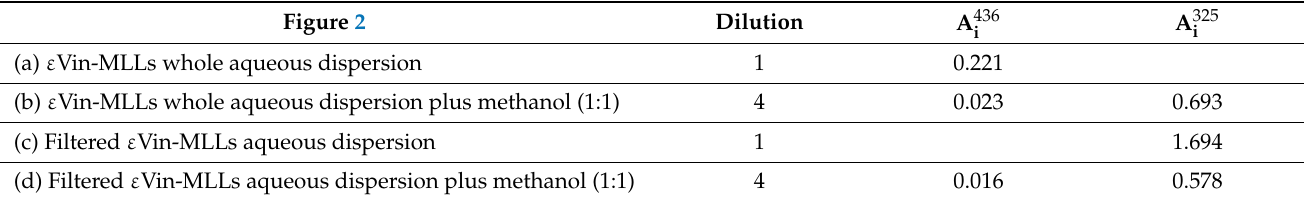
Table 1. Values of absorbance measured at 436 nm (MLLs) and 325 nm ( ε Vin) for a 1 mg mL − 1 dispersion of ε Vin-loaded MLLs containing 40 µ g mL − 1 of ε Vin. Filtration was realized with 5 µ m pore-sized PVDF filters. MLLs were disrupted by addition of an equal volume of methanol. The standard deviation is ± 0.006.